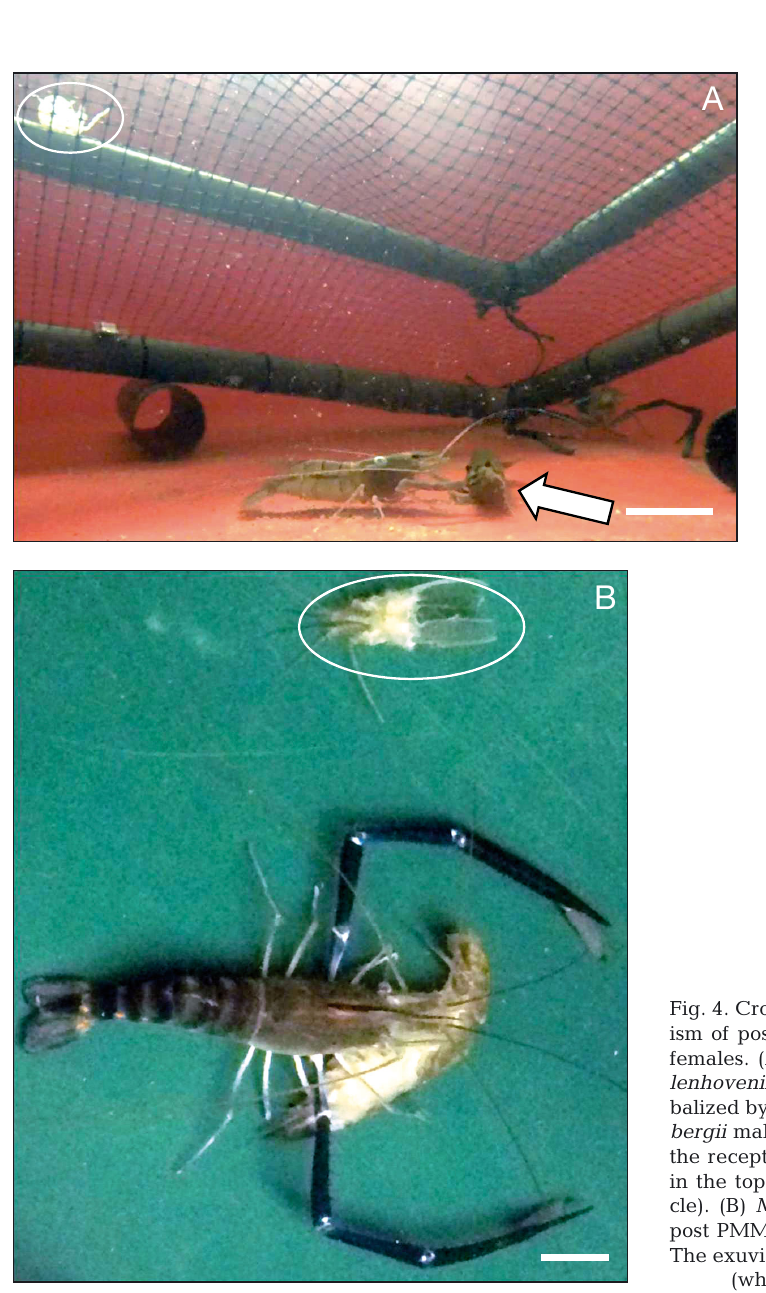
Table 3. Artificial insemination of Macrobrachium vollenhovenii (Mv) females using M. vollenhovenii spermatophores (Mv × Mv) or M. rosenbergii (Mr) spermatophores (Mv × Mr). Insemination attempts: number of artificial insemination procedures that were conducted; eggs laid: number of females that laid eggs following the artificial insemination; eggs not laid: number of females that did not lay eggs following the artificial insemination attempt; eggs hatched: number of egg clutches that successfully hatched following the artificial insemination; eggs discarded: number of egg clutches that were laid following the artificial insemination, but were discarded; dead female: number of females that died following the artificial